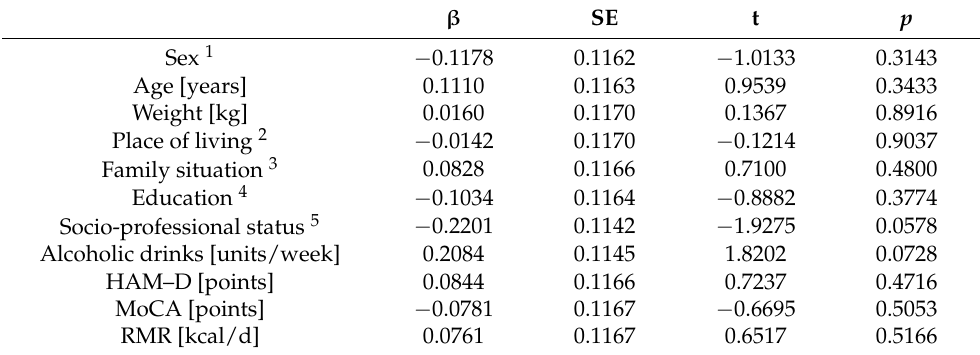
Table 8. Univariate linear regression analysis assessing the relationship between total physical activity [MET—min/day] measured by IPAQ and selected variables in the total study population ( n = 75).